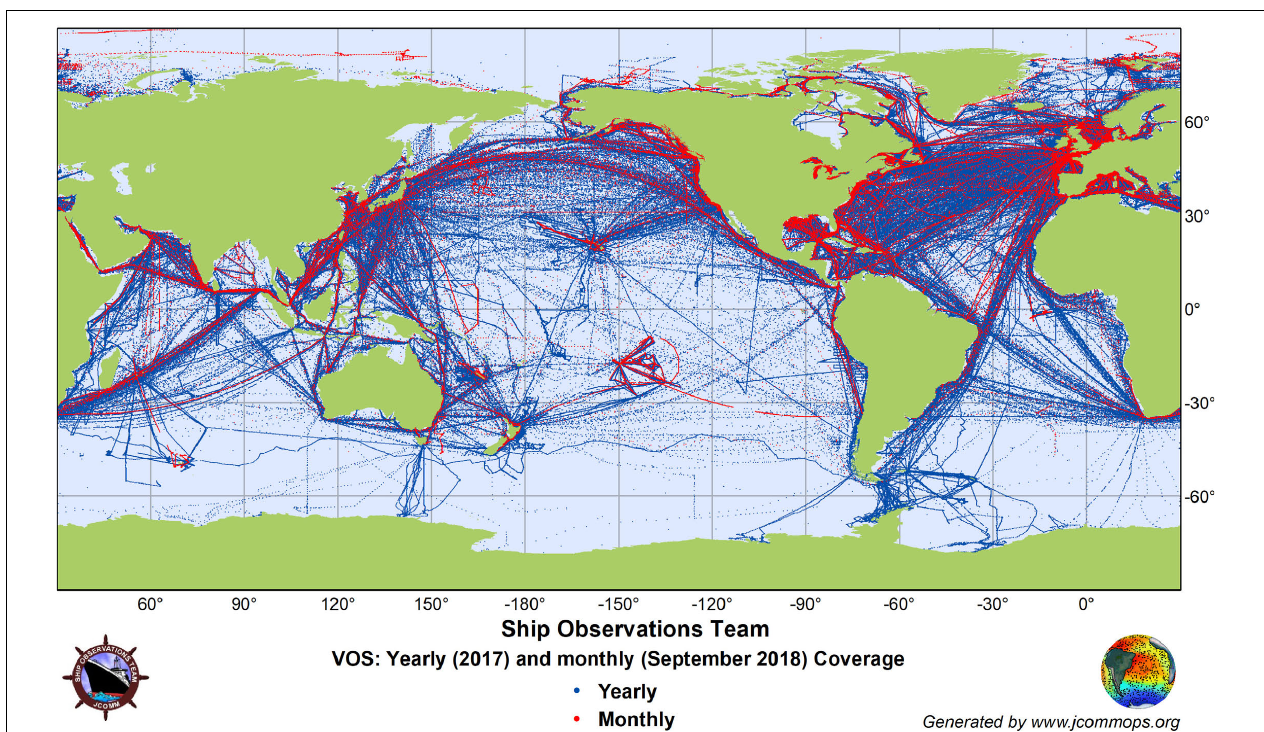
FIGURE 5 | Coverage of the ocean vessels participating in the VOS Scheme (including both character-based and BUFR reports) on monthly (red, September 2018) and yearly (blue, 2017) bases. While approximately 2,000 vessels contributed in total, more than 90% of the data are submitted by fewer than 600